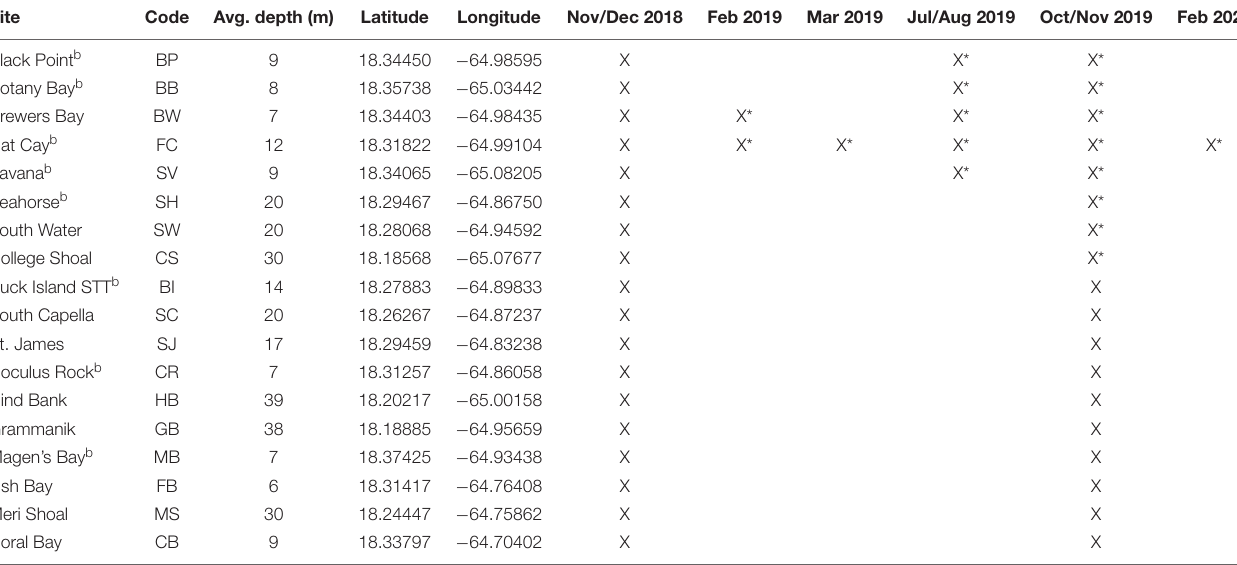
TABLE 1 | Sampling time points at USVI TCRMP locations in the northern USVI (STT: St. Thomas, STJ: St. John).